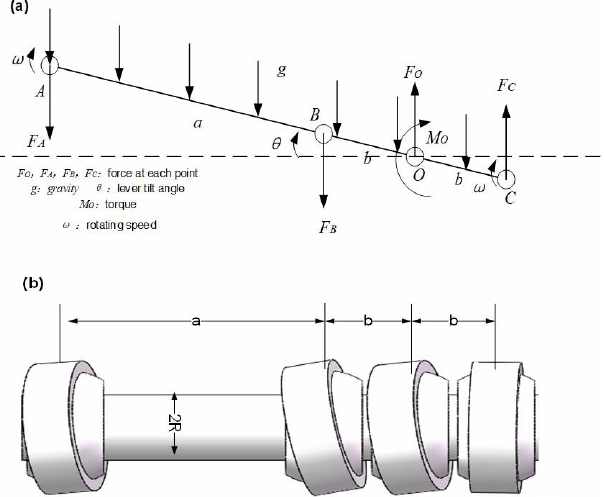
Figure 4. Lever mechanism. (a) Schematic diagram of the simpli- fied lever mechanism and (b) schematic diagram of the lever struc-